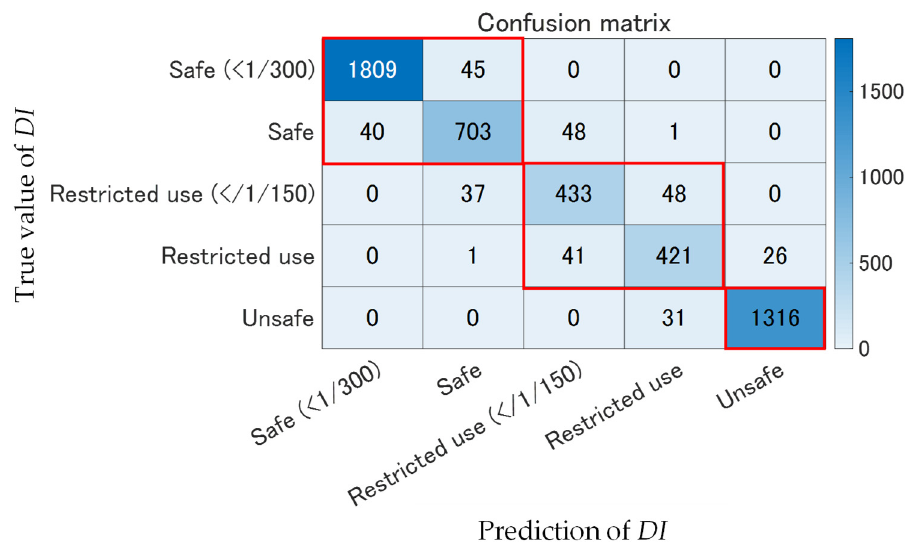
Figure 10. Safety evaluation using the confusion matrix.